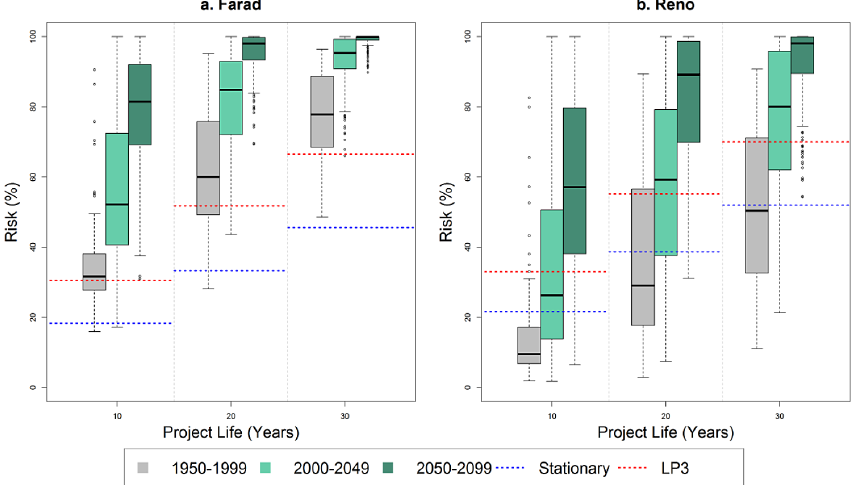
Figure 6. Box plots of the probability of a 1-day flood exceeding 1065cms (risk) for three project life lengths (10, 20 and 30 years). Results are grouped by time period (1950–1999, 2000–2049 and 2050–2099). Blue dashed lines show the flood risk calculated from the stationary GEV model fit to the historical